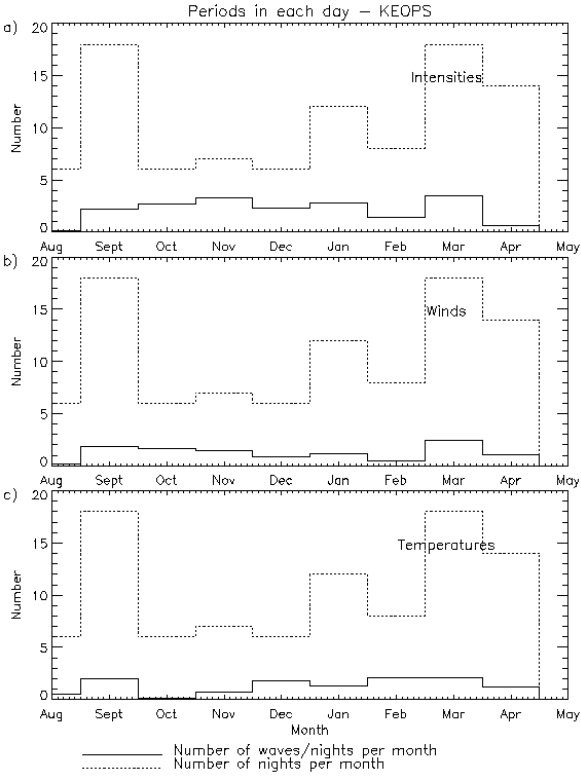
Fig. 14. Histogram of gravity wave periods for all nights and all ac- tivity levels, from KEOPS data over the winter season of 2000–2001 (solar maximum): (a) intensities, (b) winds, and (c) temperatures.